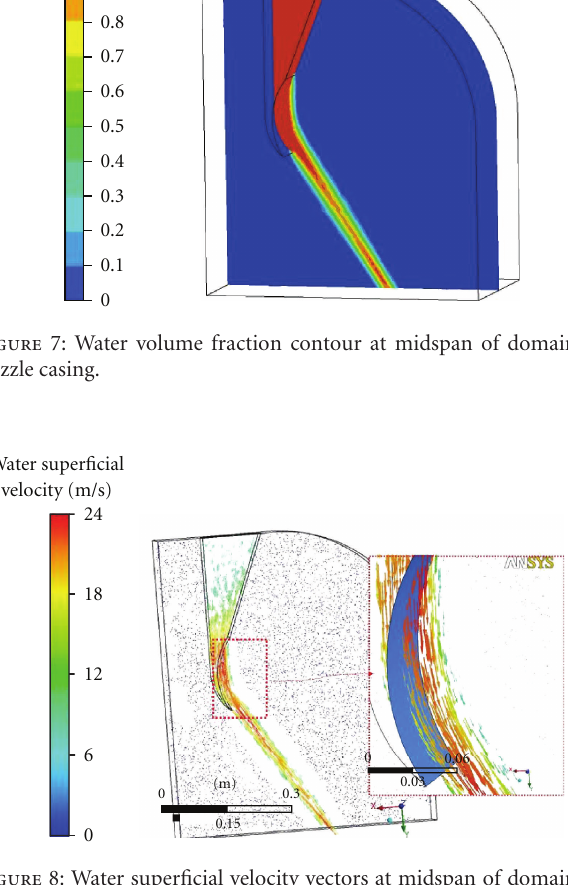
Figure 6: Schematic view of rotation angle θ measuring and general cylindrical coordinates.